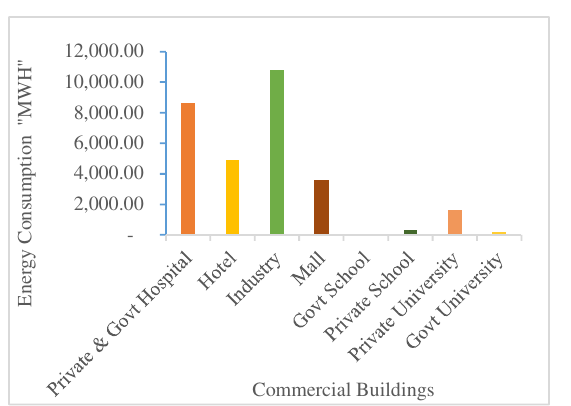
Fig. 9: Temperature Change of Karachi